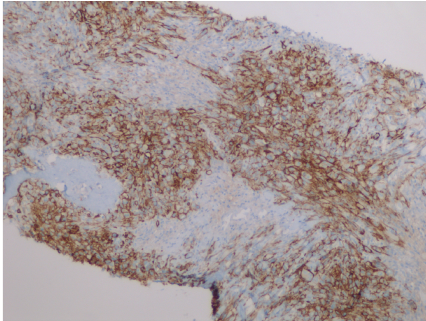
Figure 6: Resection specimen, chest wall tumor, H&E 5x: the epithelioid component is evident in the invaded lung parenchyma.